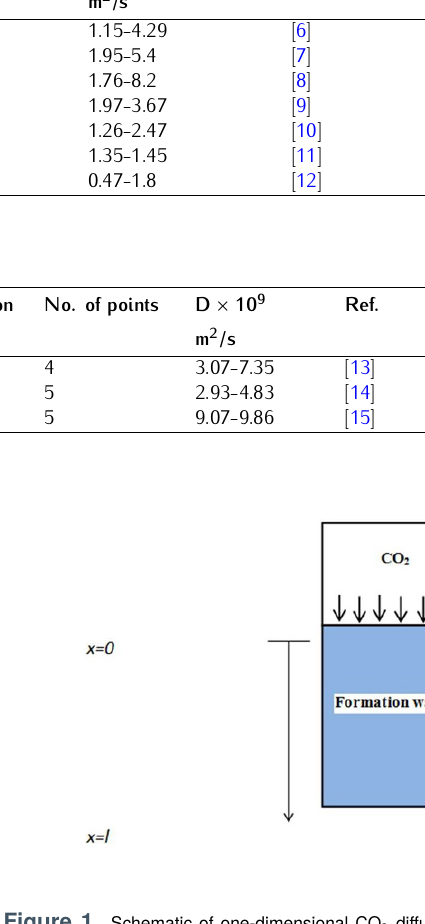
Table 1. Summary of experimental studies on CO Temperature range